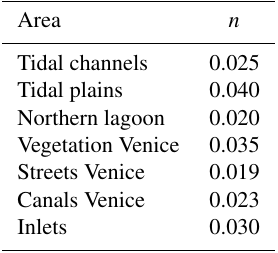
Table 3. Applied roughness values.